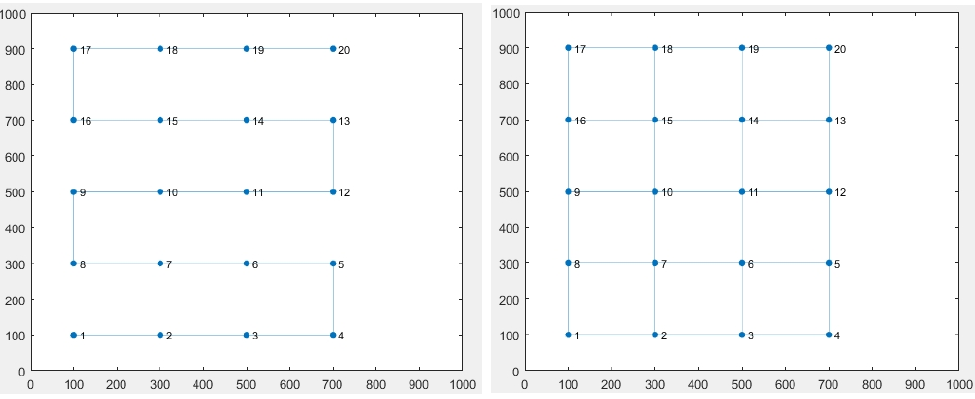
Figure 8. Fixed communication topologies for 20 robots.